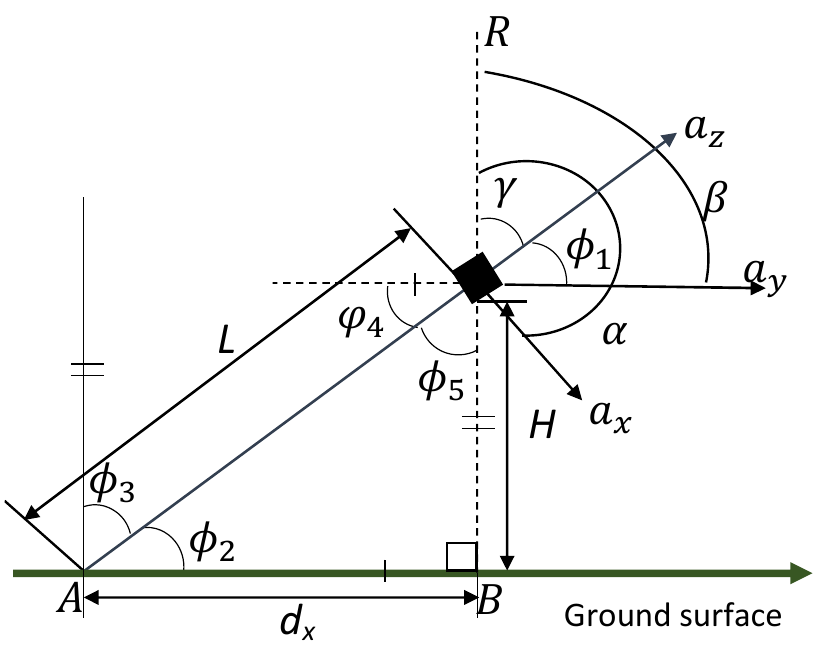
Figure 2. Sway projection based on the inverted pendulum [30]. L represents the distance of the COM position to the ground which is assumed to be constant for each individual. The resultant acceleration is shown as R . The angles made by each directional acceleration a x , a y, and a z are shown as α , β , and γ respectively. They are obtained from their directional cosines cos( α ), cos( β ), and cos( γ ) respectively. The angles φ 1 , φ 2 , φ 3 , φ 4 , and φ 5 are used for mathematical justifications. The ground displacements from the origin in the x and y directions are d x and d y respectively and H represents the ground projection of the COM height. Equations (3)–(5) describe the algorithm’s operation. The units for distance, acceleration and angle were chosen as centimeters (cm), centimeters per second square (cm/s 2 ), and degrees (°) respectively.